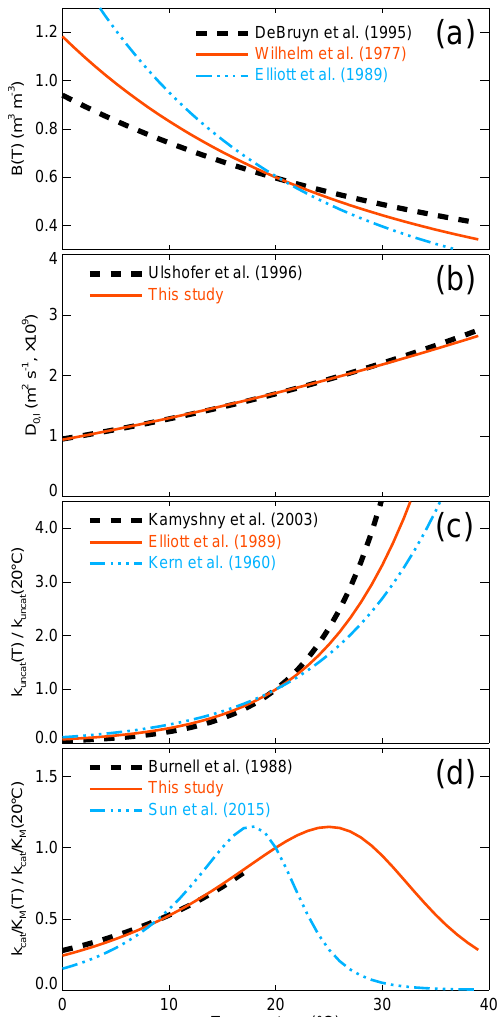
Figure 1. Temperature response of (a) the OCS solubility in wa- ter, (b) the OCS diffusivity in liquid water and (c) the uncatalysed and (d) CA-catalysed OCS hydrolysis rates. Red lines indicate the parameterisation used for this